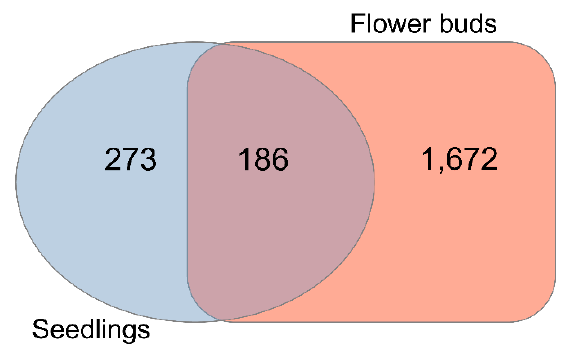
Figure 1. Differential gene expression. Venn diagram showing the number of highly differentially expressed genes (DEGs) (2-fold cutoff, false discovery rate (FDR) corrected p -value < 0.05) obtained by comparing knl2 versus wild-type ecotype Columbia-0 (Col-0) genes in seedlings and knl2 versus Col-0 genes in flower buds.